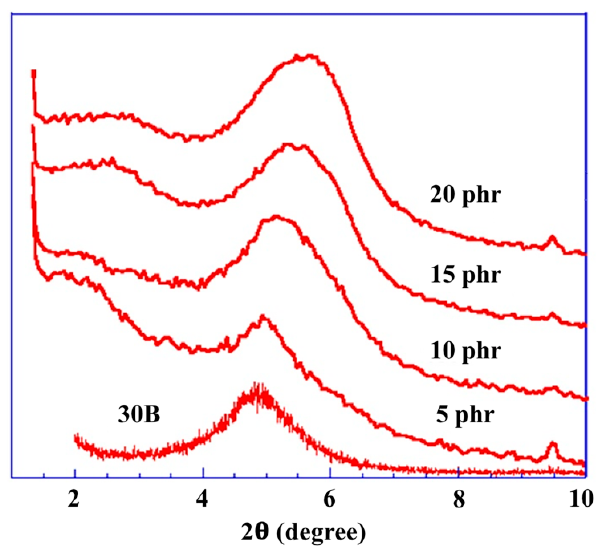
Figure 1. X-ray diffraction patterns of ethylenepropylenediene monomer/chloroprene rubber (EPDM/CR) nanorubbers with various layered-silicate contents.